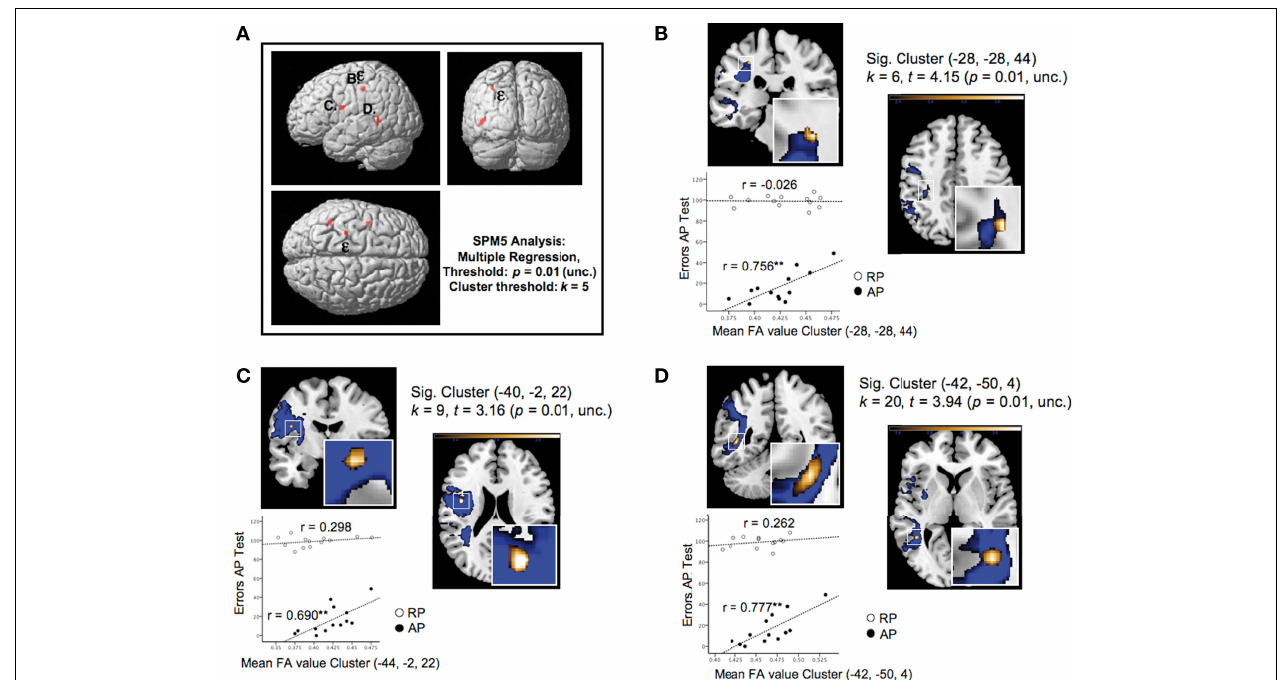
Section “Materials and Methods”). Accordingly, the error rates are plotted against mean FA values of RP and AP found by the ROI analysis. Asterisks (** p < 0.01) indicate the level of signifi cance with respect to the calculated correlational coeffi cients (Pearson’s r ). Furthermore, (B–D) provides additional information concerning the corresponding cluster [ k = number of voxels, t = highest t -value within the cluster, ( x , y , z ) = coordinates of the peak voxel of each cluster in MNI space].